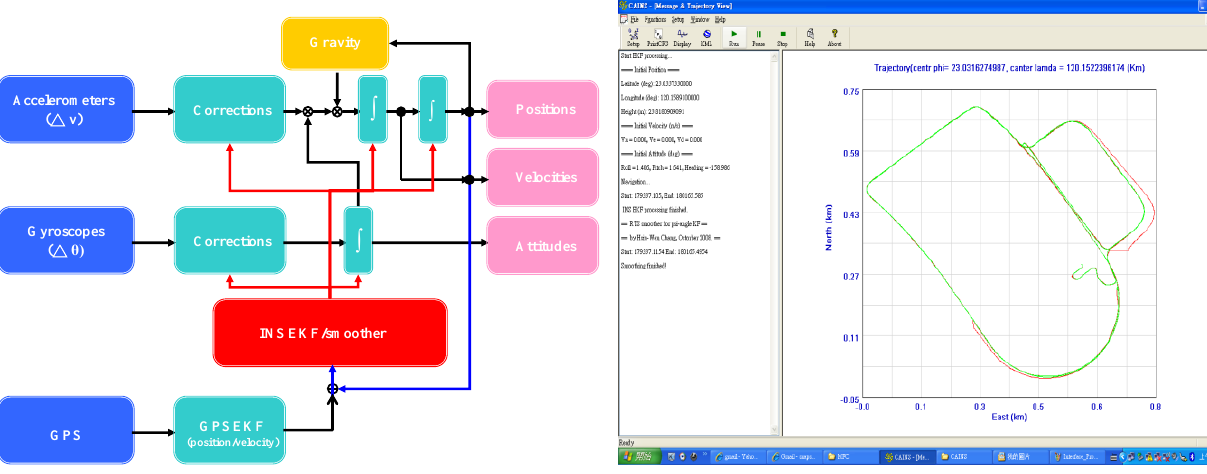
Figure 11. Loosely coupled INS/GPS integrated